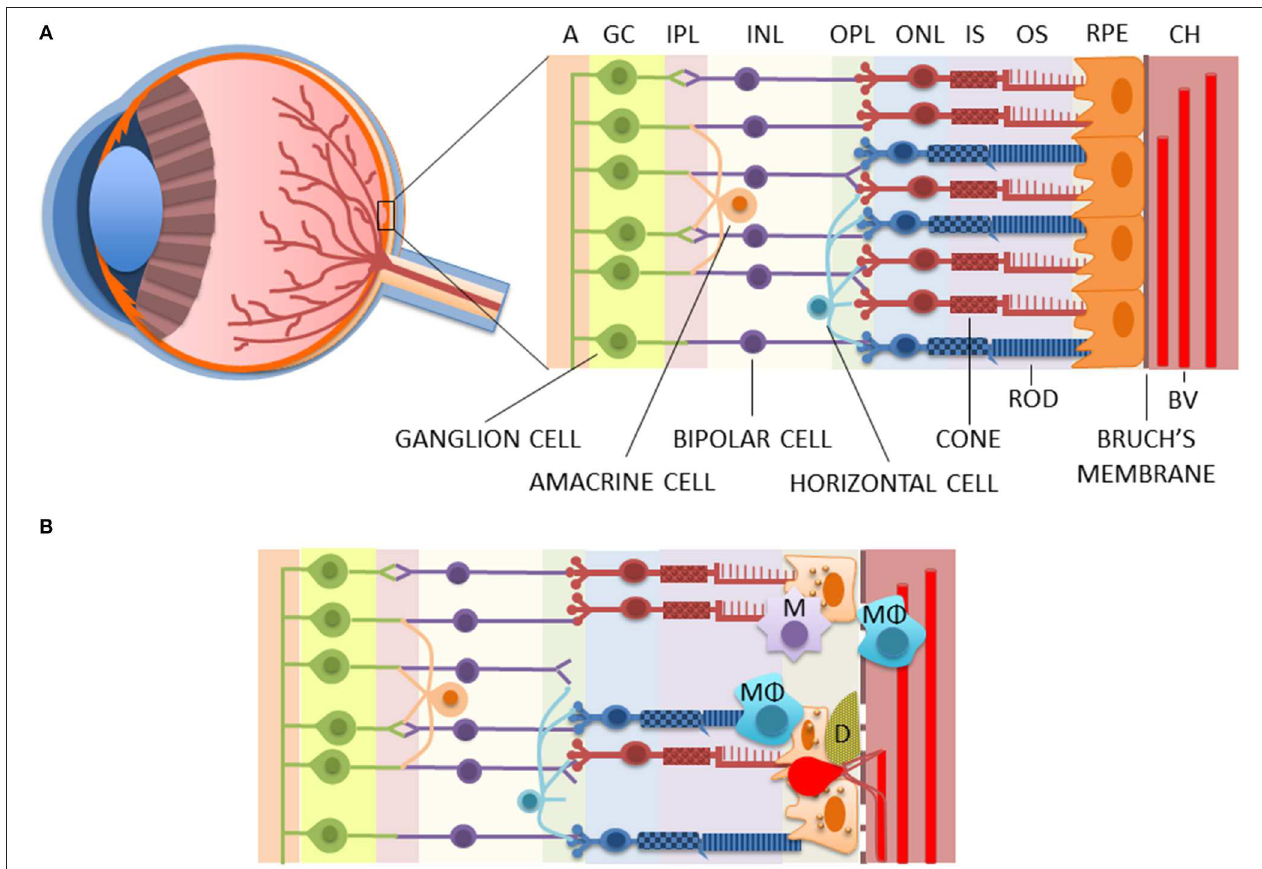
FIGURE 1 | The structure of healthy (A) and diseased (B) retinae. AMD is associated with the death of RPE and photoreceptors, rupturing of the Bruch’s membrane, the accumulation of macrophages and microglia in the choroidea and/or subretinal area, and the deposition of drusen between the RPE and the Bruch’s membrane, as well as the accumulation of lipofuscin inside the RPE cells. Moreover, in wet AMD, fragile blood vessels sprout from the choroidea in a process called choroidal neovascularization (CNV) to the retina where they leak causing edema and rapid vision loss. A, axons of optic nerves; BV, blood vessel; CH, the choroidea; D, drusen; GC, ganglion cells; INL, inner nuclear layer; IPL, inner plexiform layer; IS, inner segments of photoreceptors; M, microglia; M 8 , macrophage; ONL, outer nuclear layer; OPL, outer plexiform layer; OS, outer segments of photoreceptors; RPE, retinal pigment epithelium